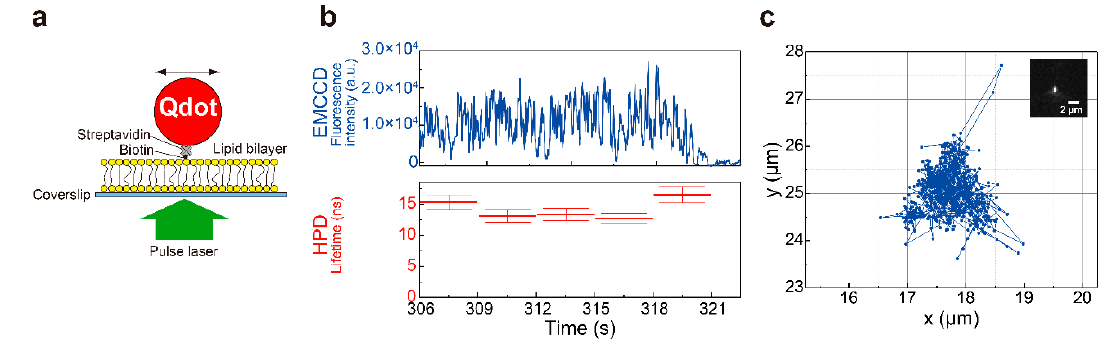
Figure 16. Wide-field single-molecule fluorescence lifetime measurement by a cooled HPD: ( a ) Schematic of the observed mobile Qdot. Sample preparation for the observation was identical to that described in the caption of Figure 15. The Qdot was excited by a pulse laser (wavelength = 520 nm); ( b ) Time courses of the Qdot fluorescence (upper, blue) obtained by an EMCCD and the lifetime (lower, red) simultaneously obtained by an HPD. The lifetime was obtained by fitting each decay curve drawn using data accumulated in three seconds with a single-exponential (red); ( c ) Trajectory of the Qdot obtained by EMCCD. The inset is a fluorescence image of the observed mobile Qdot.